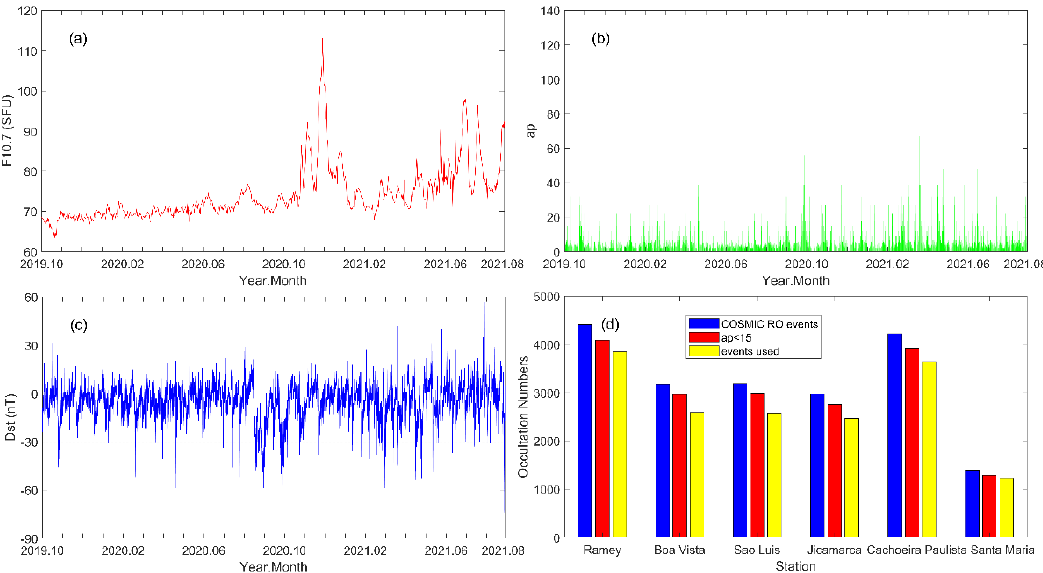
Figure 2. Daily solar-geomagnetic activities in the approximately 2-year period from October 1, 2019, to August 31, 2021. ( a ) F10.7; ( b ) ap; ( c ) Dst; ( d ) total number of COSMIC-2 EDPs over each ionosonde station.